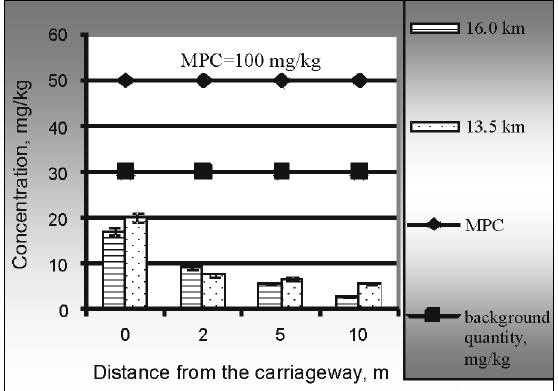
Fig. 3. Chromium concentration in the roadside soil of the gravel road Krinčinas – Žvirgždė – Šukionys – Meiliūnai